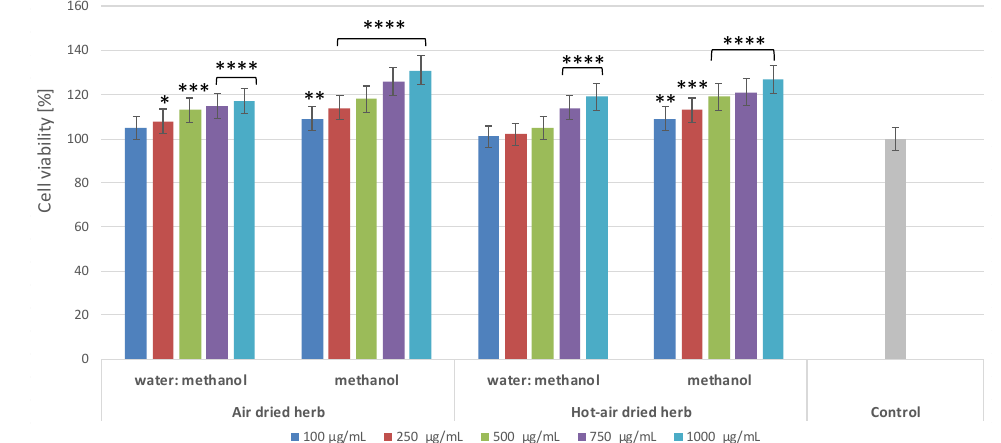
Figure 1. HPLC ‐ DAD ( λ = 254 nm, UV spectra range 200–400 nm) chromatogram of hot ‐ air ‐ dried herb methanol extract of B. officinalis ; (1) protocatechuic acid, (2) 3,4 ‐ dihydroxyphenylacetic acid, (3) p ‐ hydroxybenzoic acid, (4) chlorogenic acid, (5) caffeic acid, (6) syringic acid, (7) ferulic acid, (8) vitexin, (9) kaempferol 4 ‐ glucoside, (10) rutoside, (11) rosmarinic acid, (12) astragalin.